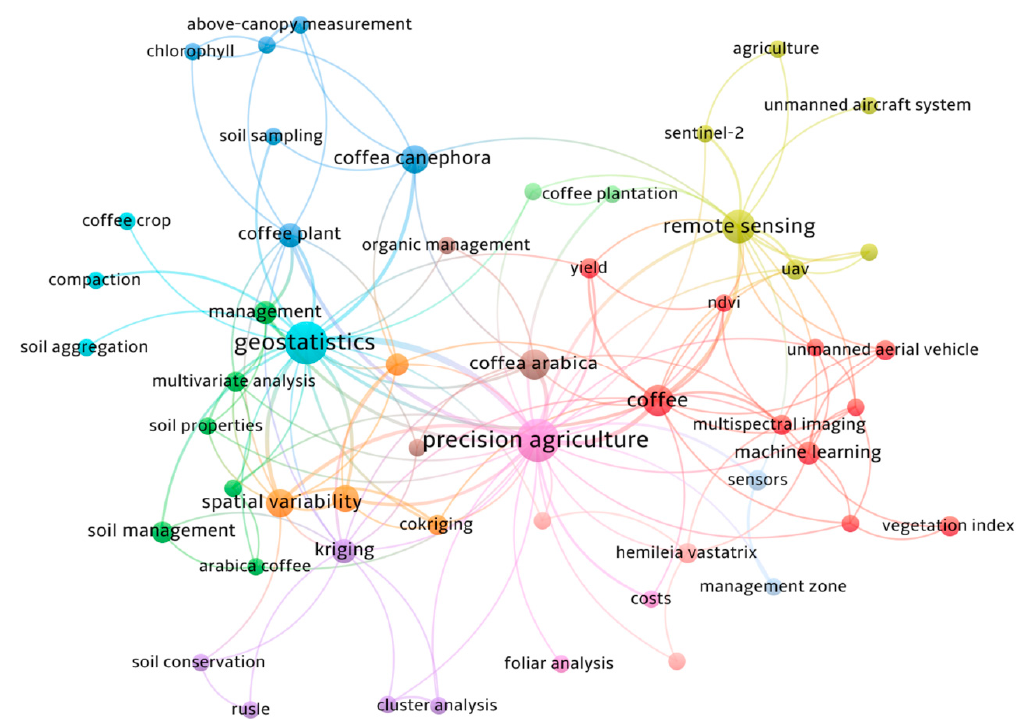
Figure 6. Map of network among author’s keywords. Lines indicate co-occurrences between terms. Yellow: remote sensing. Red: remote sensing and machine learning. Green and purple: spatial variability of soil attributes. Azul: technologies applied to the cultivation of coffee canephora. Orange: application of techniques for mapping soil attributes.